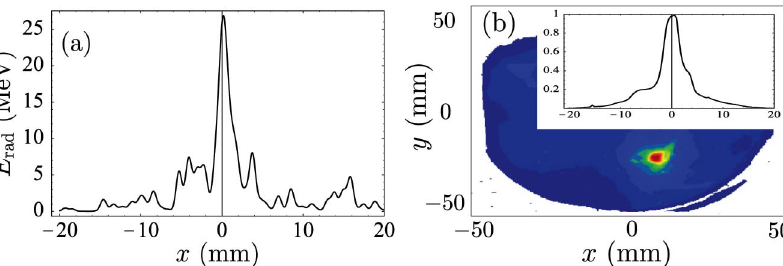
FIG. 17. (Color) Radiated energy on a phosphor screen 70 cm away from the gas jet, (a) lineout using the electron beam produced by the fully explicit PIC simulation of a channel guided laser pulse [Fig. 15] and (b) radiation from a 10 (cid:5) 10 cm phosphor screen imaged on a CCD camera, which is taken from experimental measurements with similar laser-plasma parameters. The red color highlights the largest energy deposition from the electron beam onto the phosphor and blue the smallest,